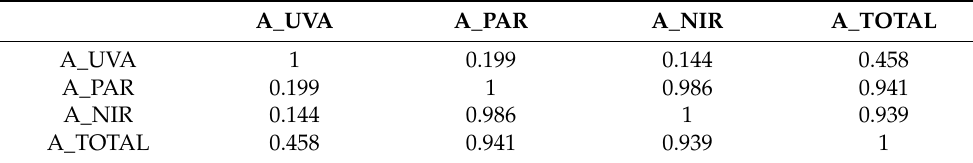
Table 5. Correlations between absorbed radiation in different regions.